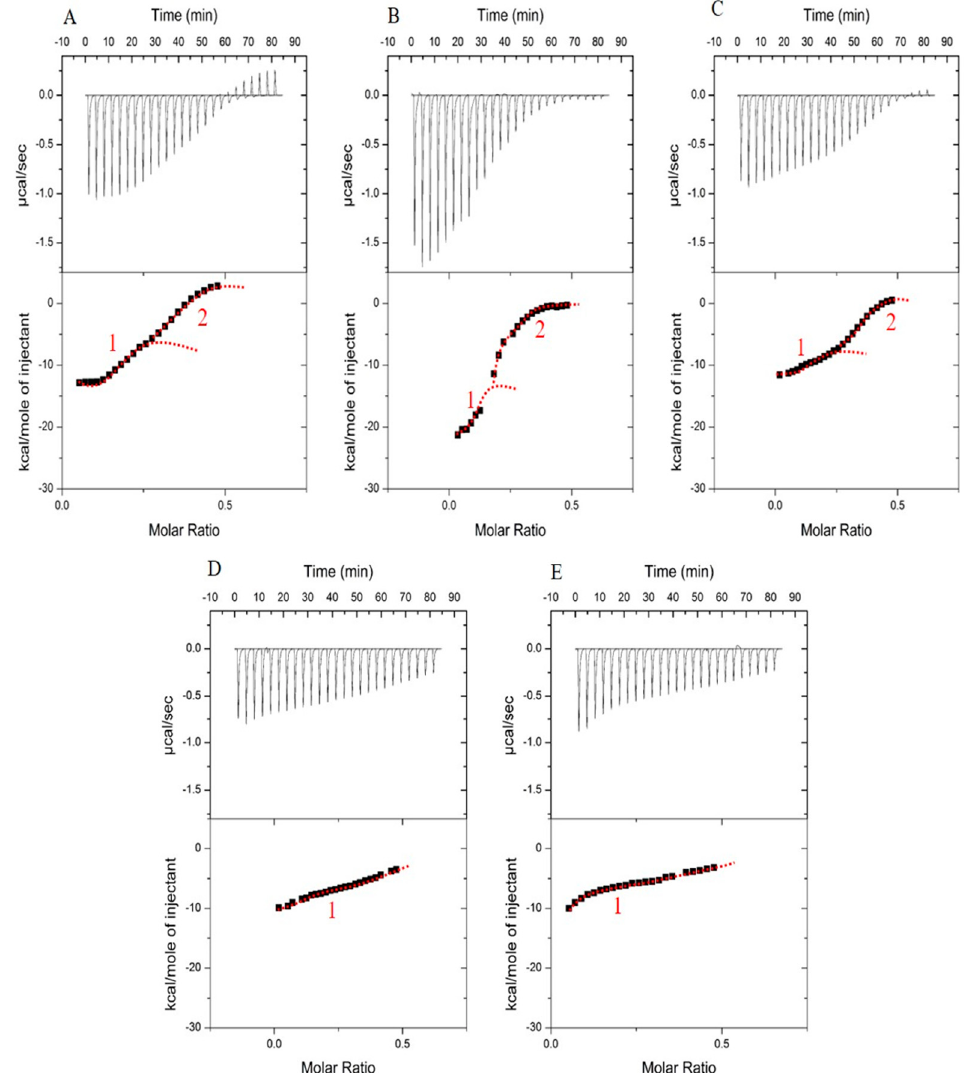
Figure 2. Heat flow thermograms as a function of time (upper panel) obtained during the titration of β LG (0.1 mM) by LF (0.25 mM) at different salt concentrations in 10 mM MES buffer pH 5.5 and at 25°C. Bottom panel: graphical representation of the integrated data of enthalpy versus the molar ratio of LF: β LG. ( A ): without added salt; ( B ): with 2.5 mM added NaCl; ( C ): with 5 mM added NaCl; ( D ): with 15 mM added NaCl; ( E ): with 20 mM added NaCl. The red line is just to guide the eyes to distinguish when applicable the two inflection points. Inflection points are indicated by numbers 1 and 2.